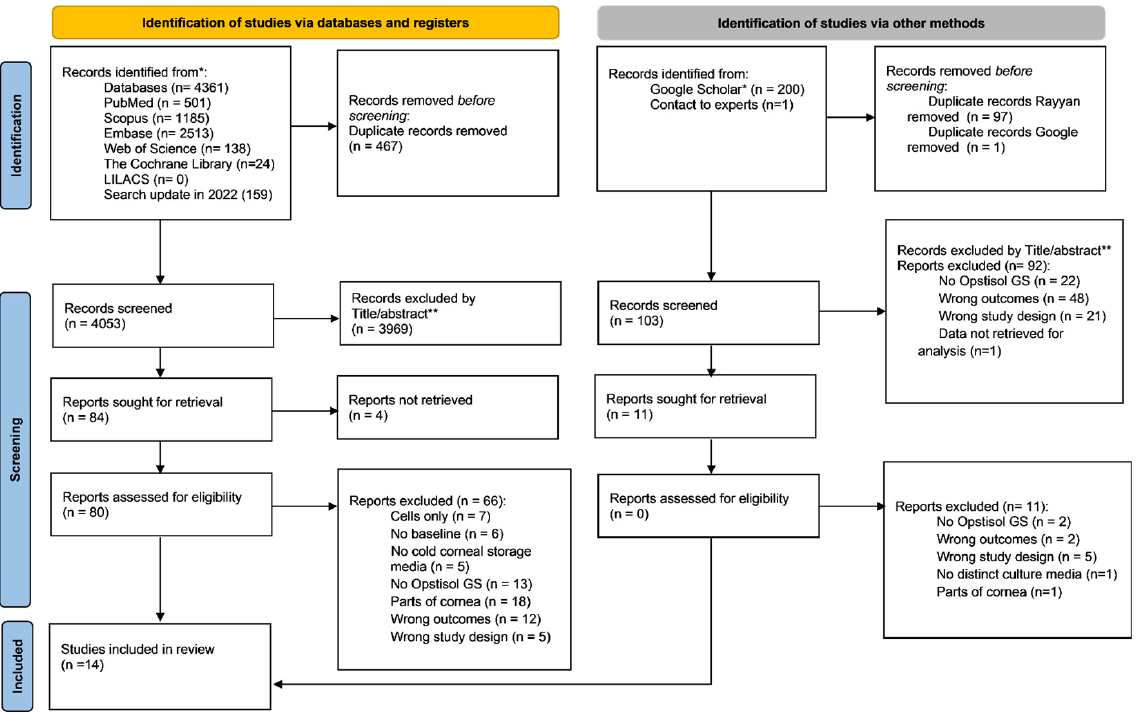
Figure 1. PRISMA 2020 flow diagram of the screening and selection